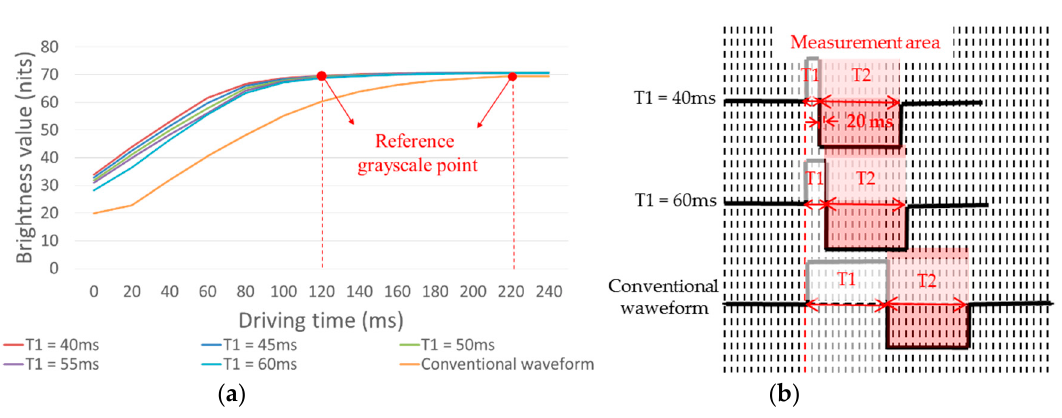
Figure 5. The influence of T1 timing on T2. ( a ) The brightness curve of T2. ( b ) The driving waveform used in the measurement.